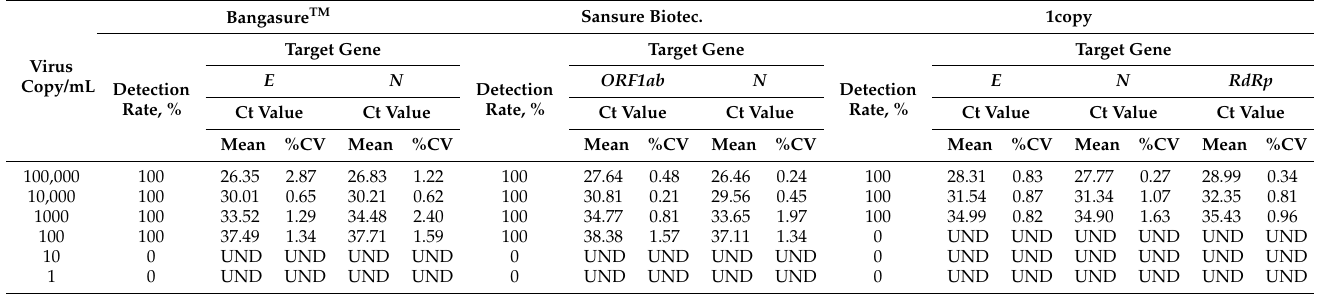
Table 2. Determining the Limit of Detection (LoD) for the Bangasure TM in-house assay and the two commercial kits using specimens with known copies of replication-deficient alphaviruses incorporat- ing the whole SARS-CoV-2 genome.